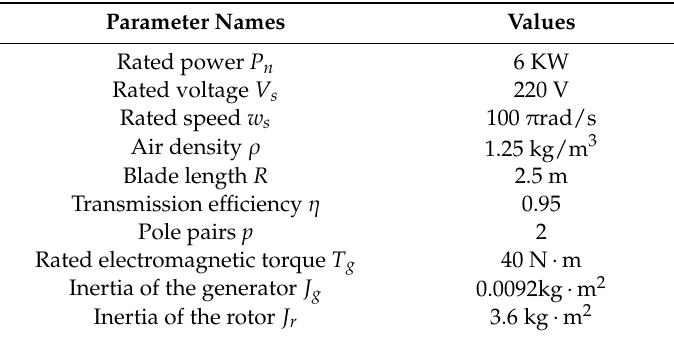
Table 1. Simulation